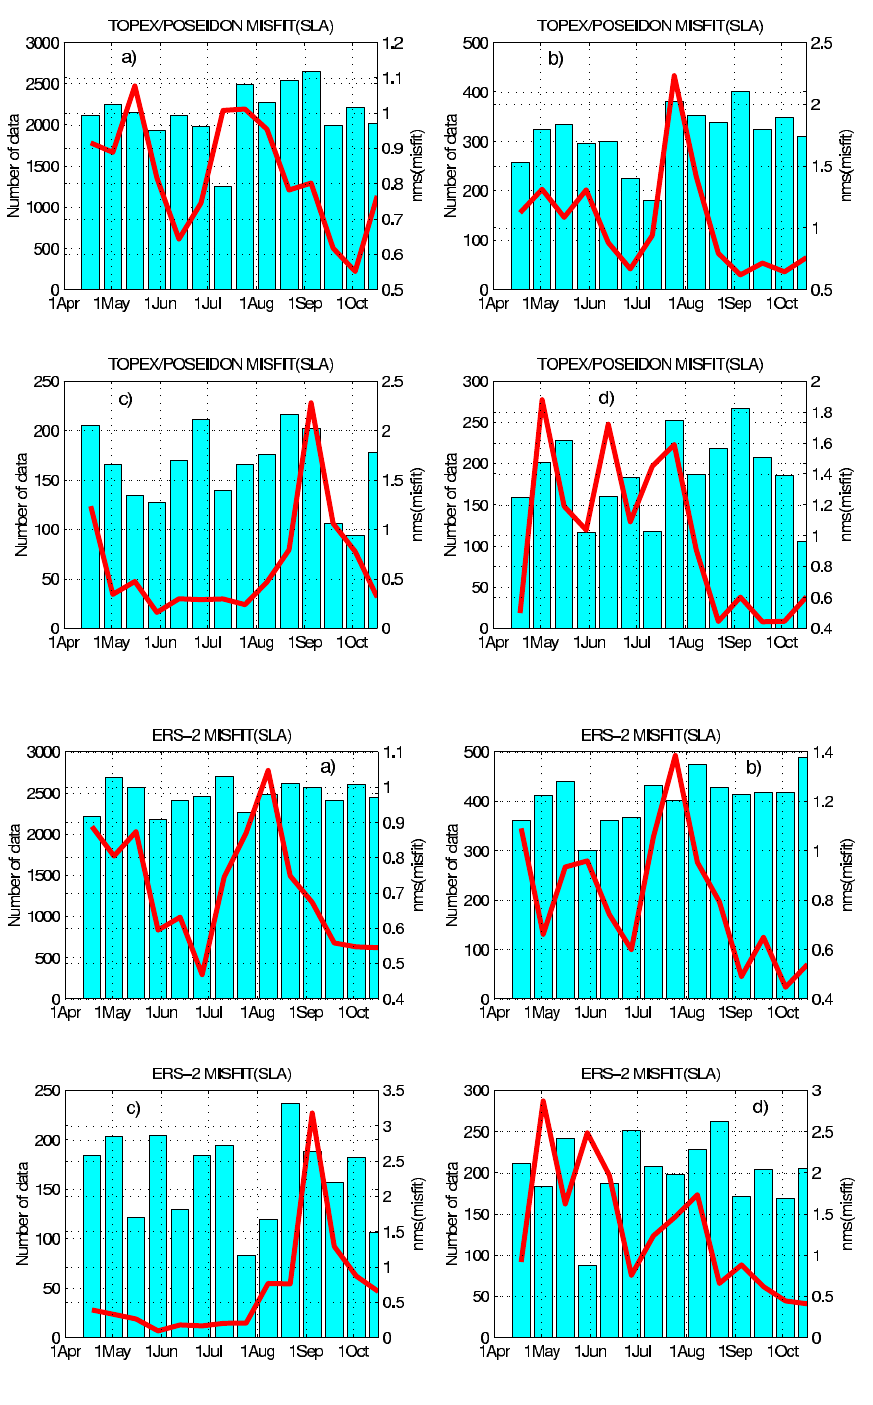
Fig. 13. Normalized root mean square misfit of SLA (Eq. 3) computed for ERS-2 data for (a) whole basin; (b) Al- gerian Basin; (c) Tyrrhenian Sea; (d) Ionian Sea. The blue bars indicate the number of SLA observations available during every bi-weekly analysis